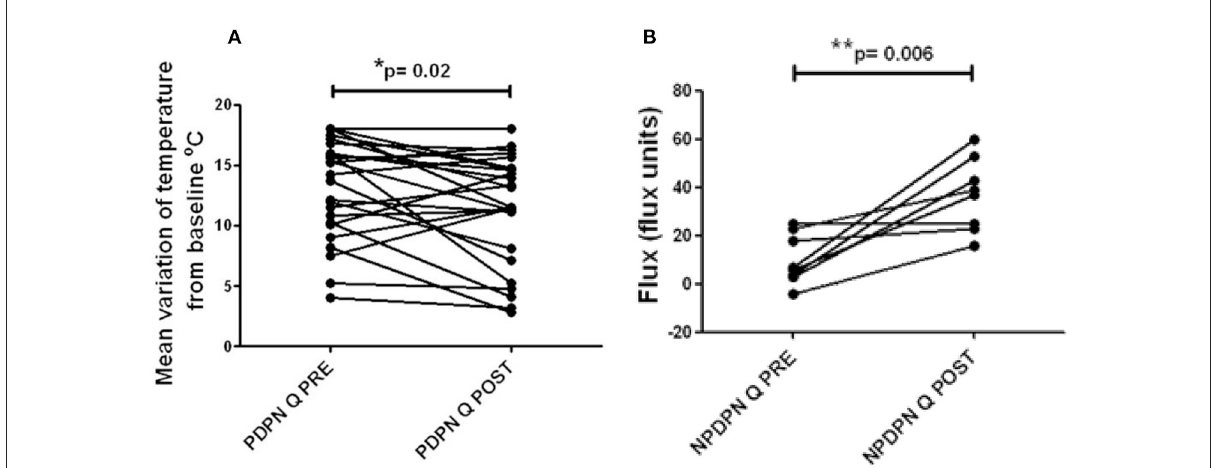
FIGURE5 Warm thermal thresholds in patients with DPN. (A) Thermal thresholds for warm perception (changes from baseline at 32 ◦ C), in PDPN Q + SOC group treated with capsaicin 8% patch Qutenza (Q), at pre–treatment visit (Q PRE) and visit 3 months after treatment (Q POST). Statistically significant difference (improvement) 3 months after the treatment (* p = 0.02; paired t –test). (B) Axon reflex vasodilatation flux in patients with NPDPN group treated with capsaicin 8% patch Qutenza (Q) at pre–treatment visit (Q PRE) and visit 3 months after treatment (Q POST). Statistically significant difference (improvement) 3 months after the treatment (* p = 0.006; paired t –test).